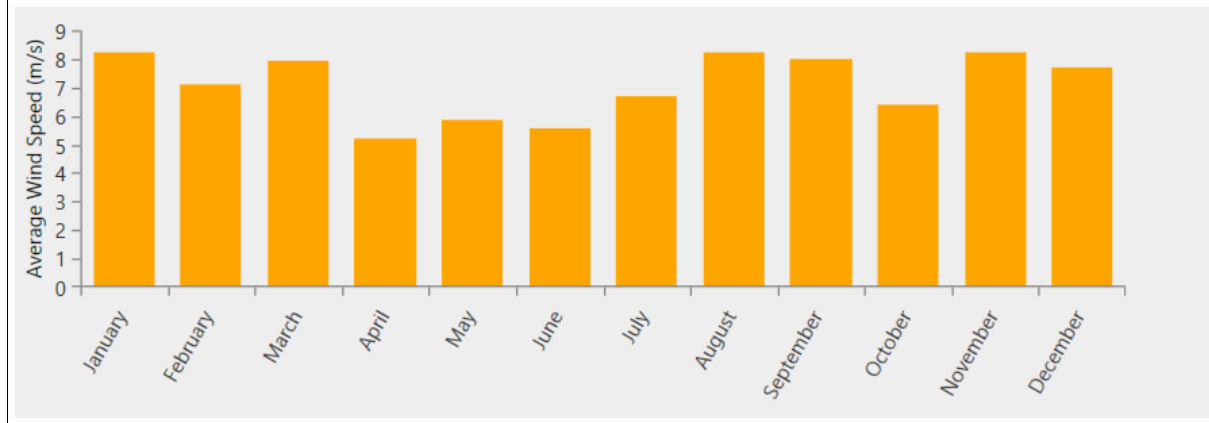
Figure 4. Average monthly wind speed of Donoussa